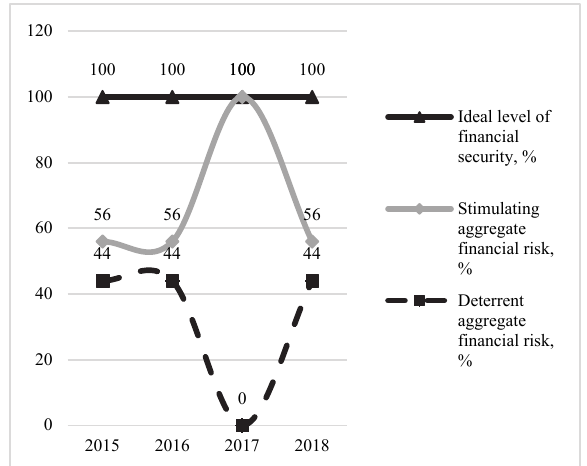
Fig. 8. Impact of restraining financial risk on the financial security level of PJSC “Elektrothermomethriya” in 2015- 2018,